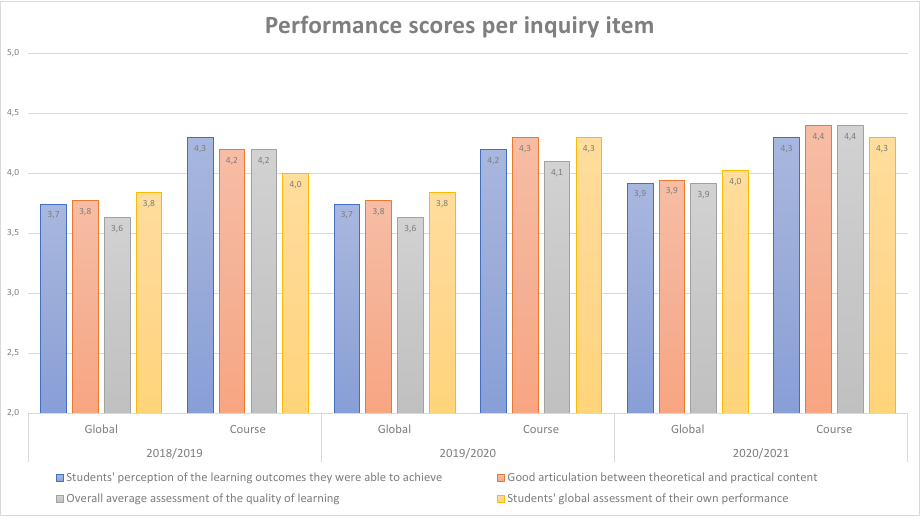
Figure 25. Students’ inquiries